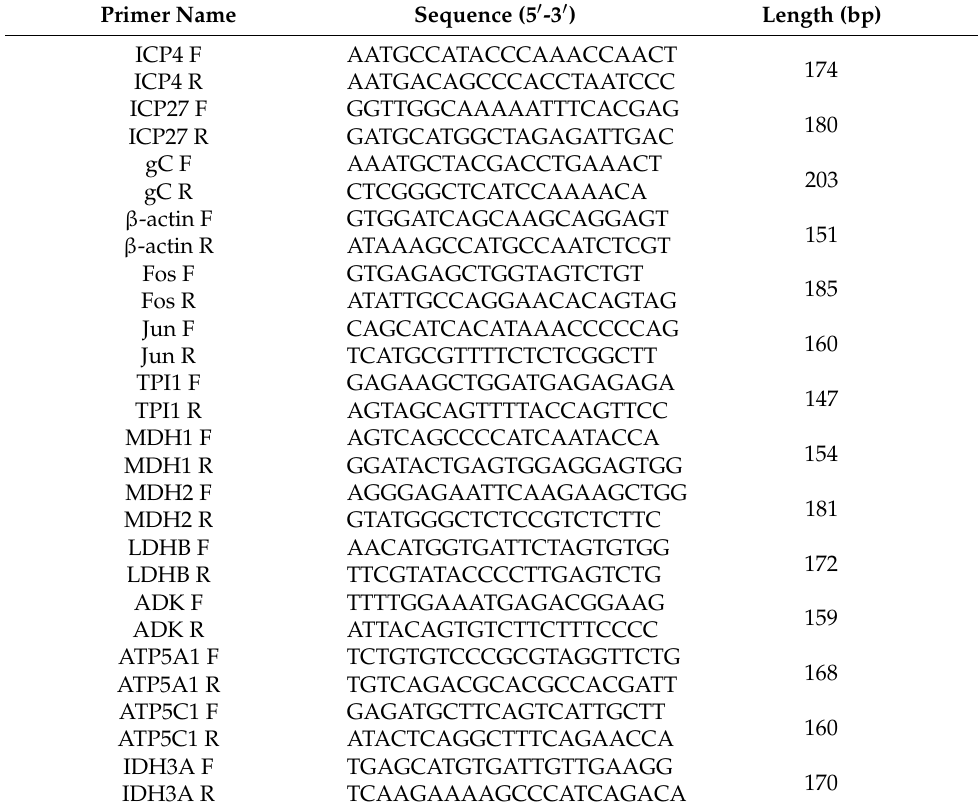
Table 2. Primer sequence for